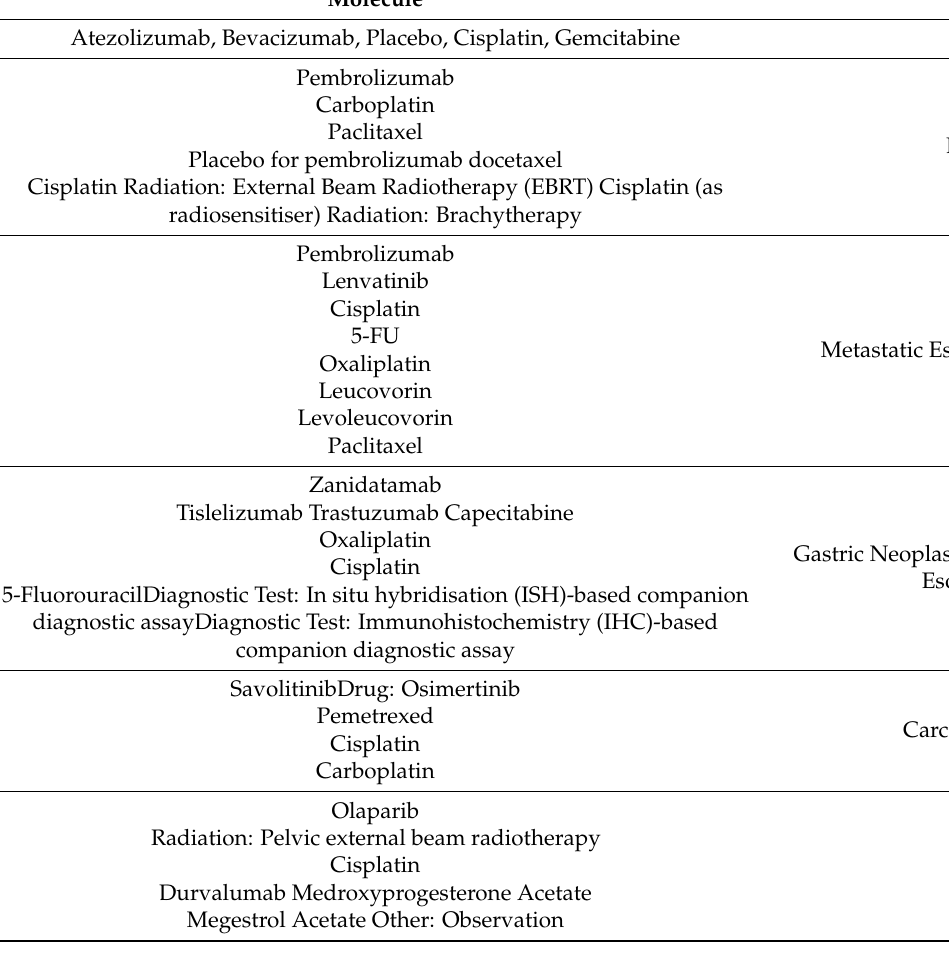
Table 2. Recent clinical trials on Cisplatin. Molecule Cancer